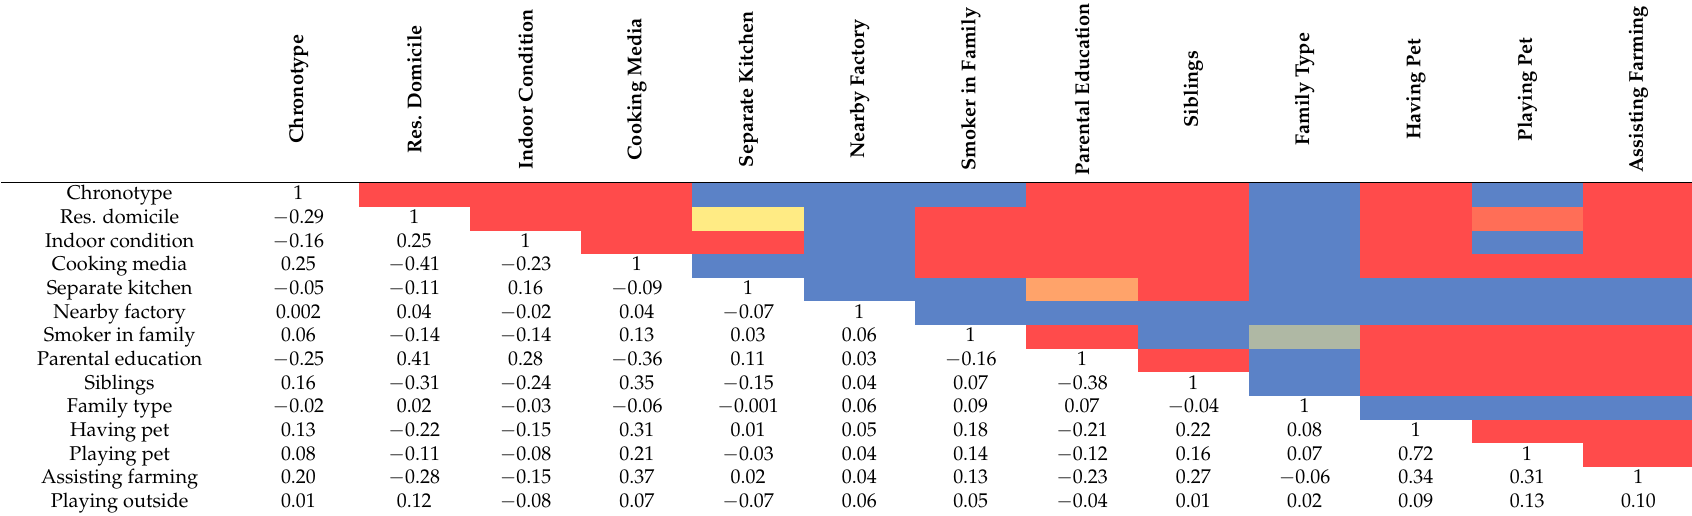
Table 2. Correlation between living conditions/socioenvironmental factors and chronotype.